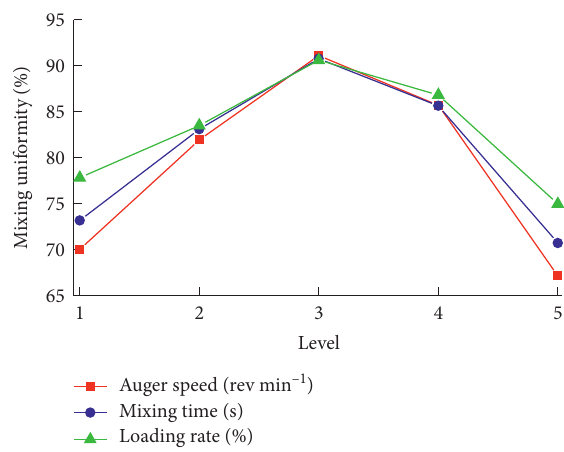
Figure 16: Influence of each simulation factor on mixing